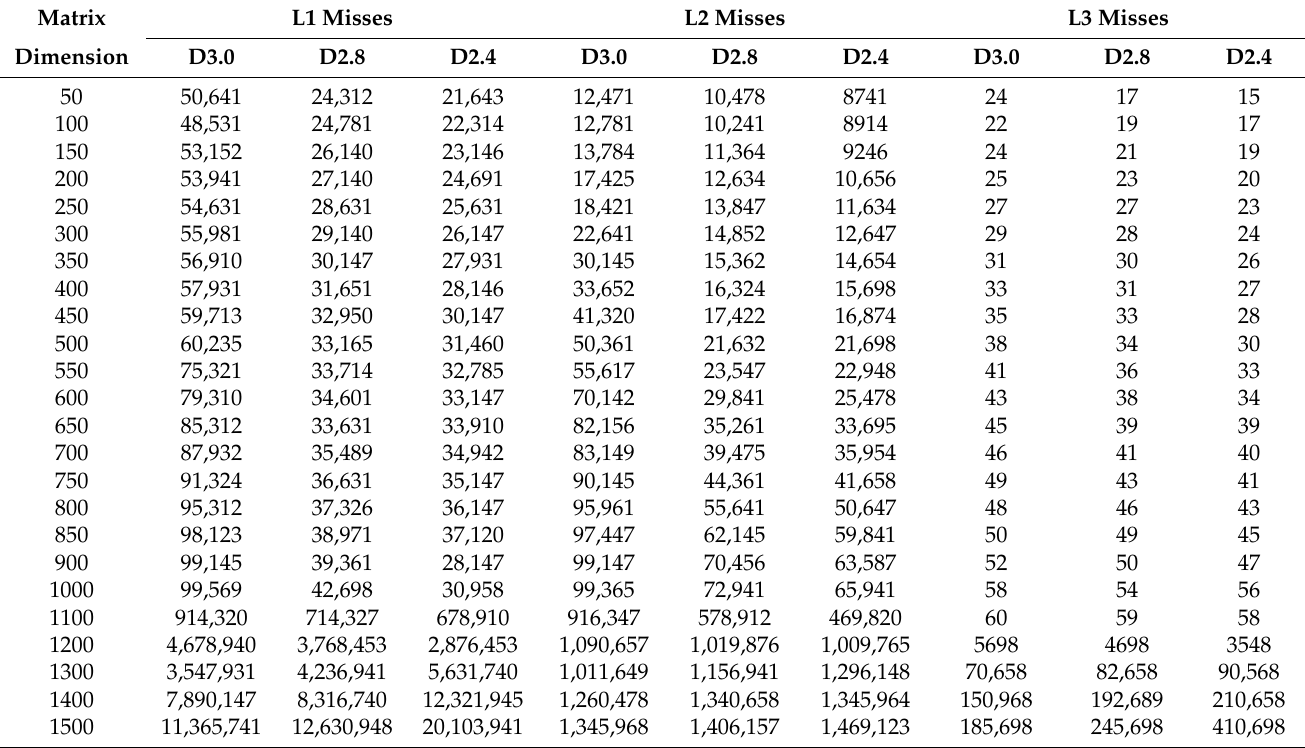
Table 3. Average cache miss from reported internal counter